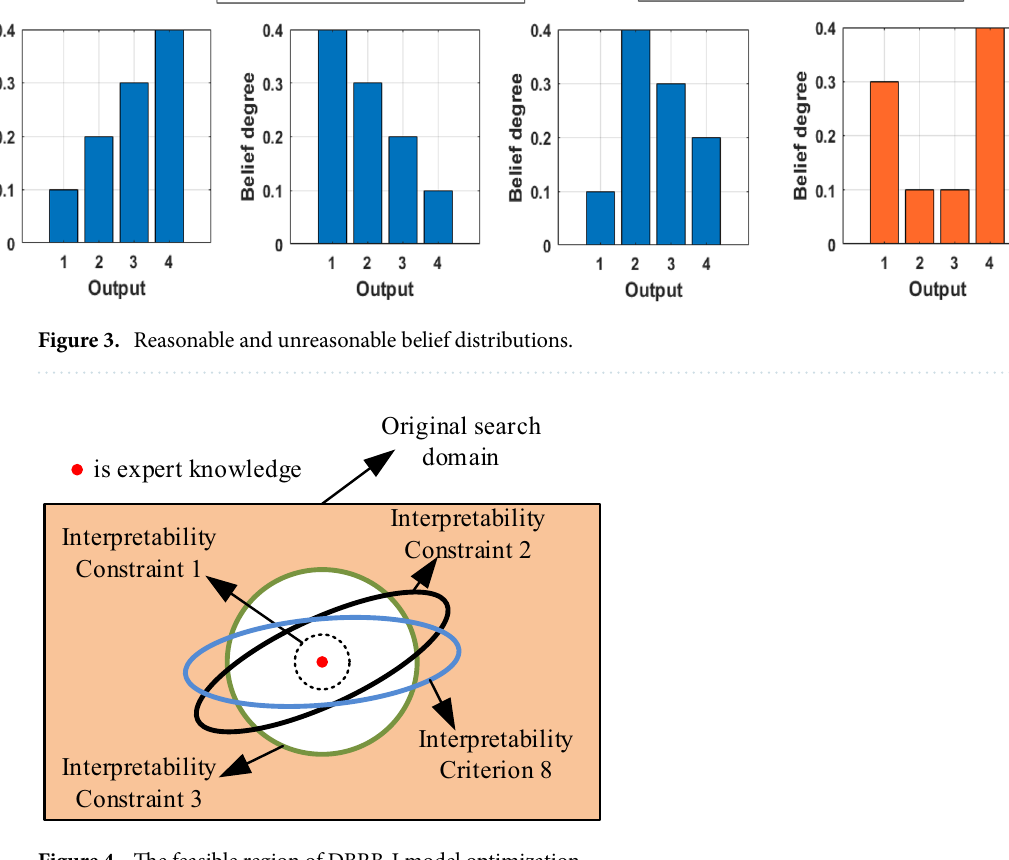
Figure 4. The feasible region of DBRB-I model